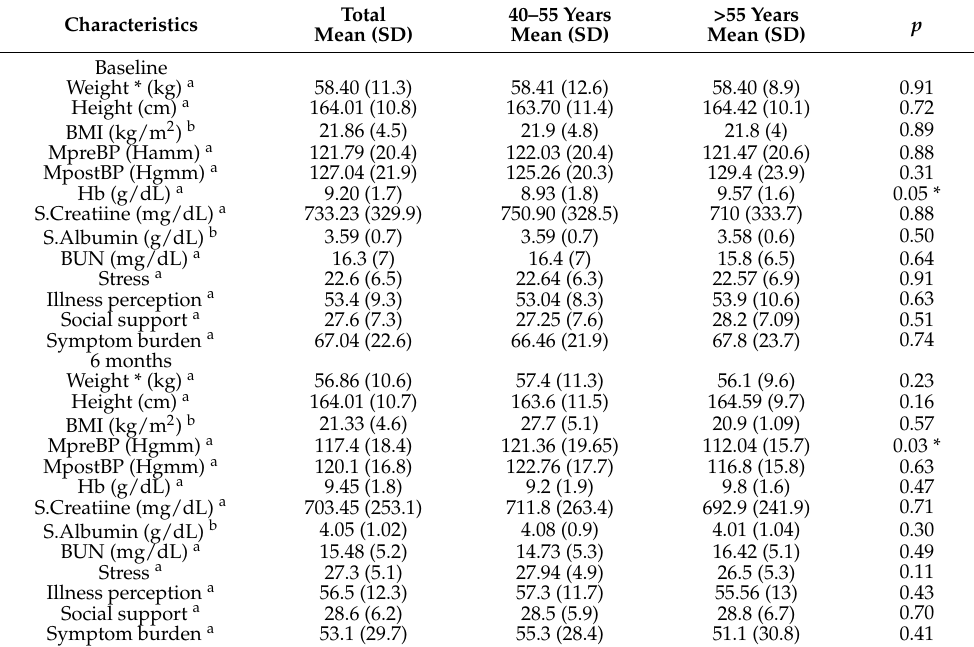
Table 2. Anthropometric, clinical parameters, psychosocial factors and symptom burden by age group.